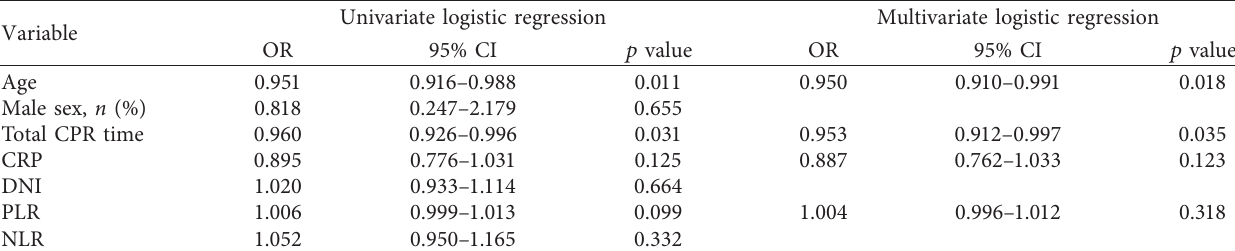
Table 4: The predictive factors for the tertiary outcome (good neurological